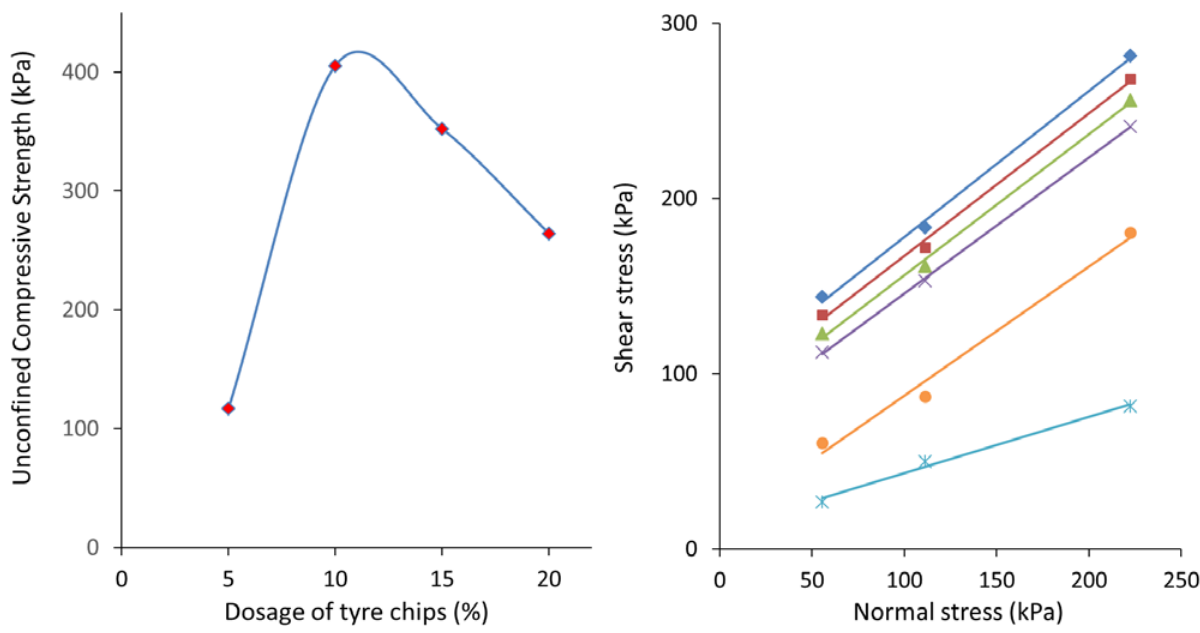
Figure 6. Results of direct shear tests for different soil specimens, with Mohr-Coulomb lines fitted. In each case, cohesion (c) is given by the y-intercept and angle of internal friction (φ) by the slope of the line. For the key to specimen treatments, see Figure